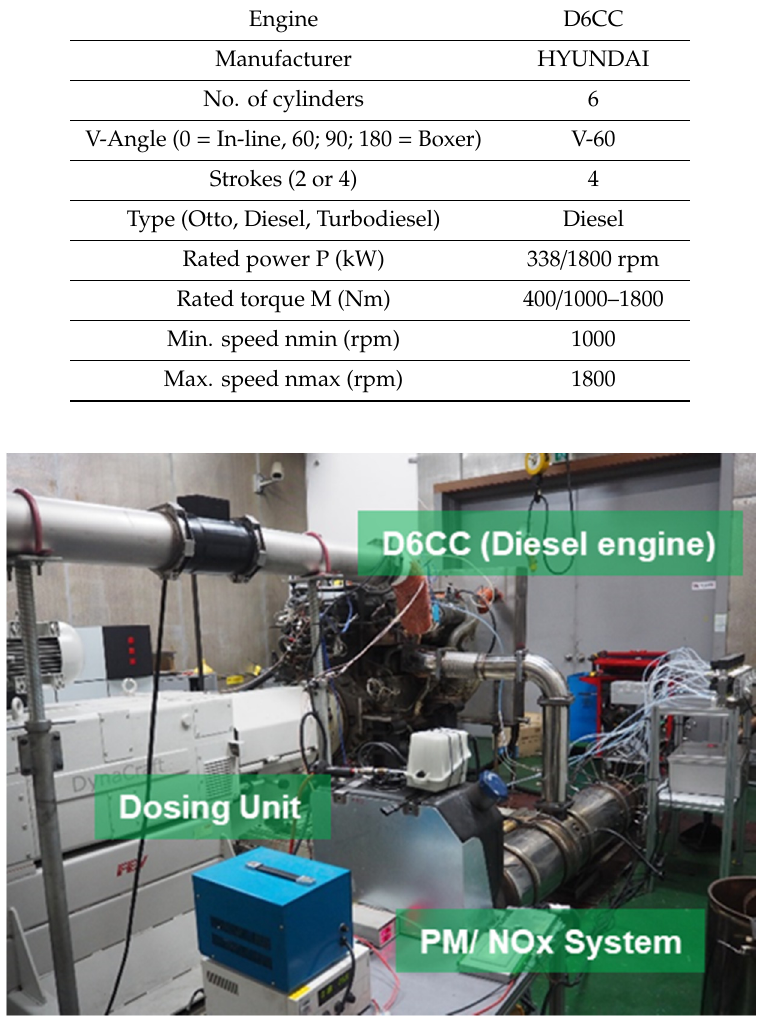
Figure 15. Experimental test and engine measurement setup.